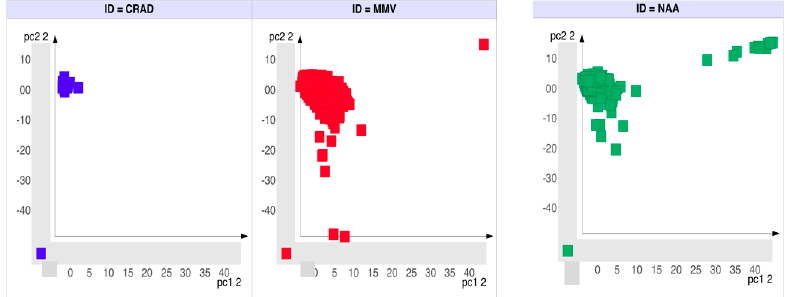
Figure 4. Scaffold structural similarity assessment using principal components analysis. Structural similarity between Level 1 scaffolds of natural products with antiplasmodial activities (NAA) and public malarial screen data (MMV) were assessed. “Skelspheres descriptors” from Datawarrior were used to assess structural similarity and generate principal components. The 3D plot of the first three principal components showed that most of the scaffolds from NAA occupy the same chemical space as scaffolds from MMV. However there were NAA scaffolds that were outliers from the main cluster.